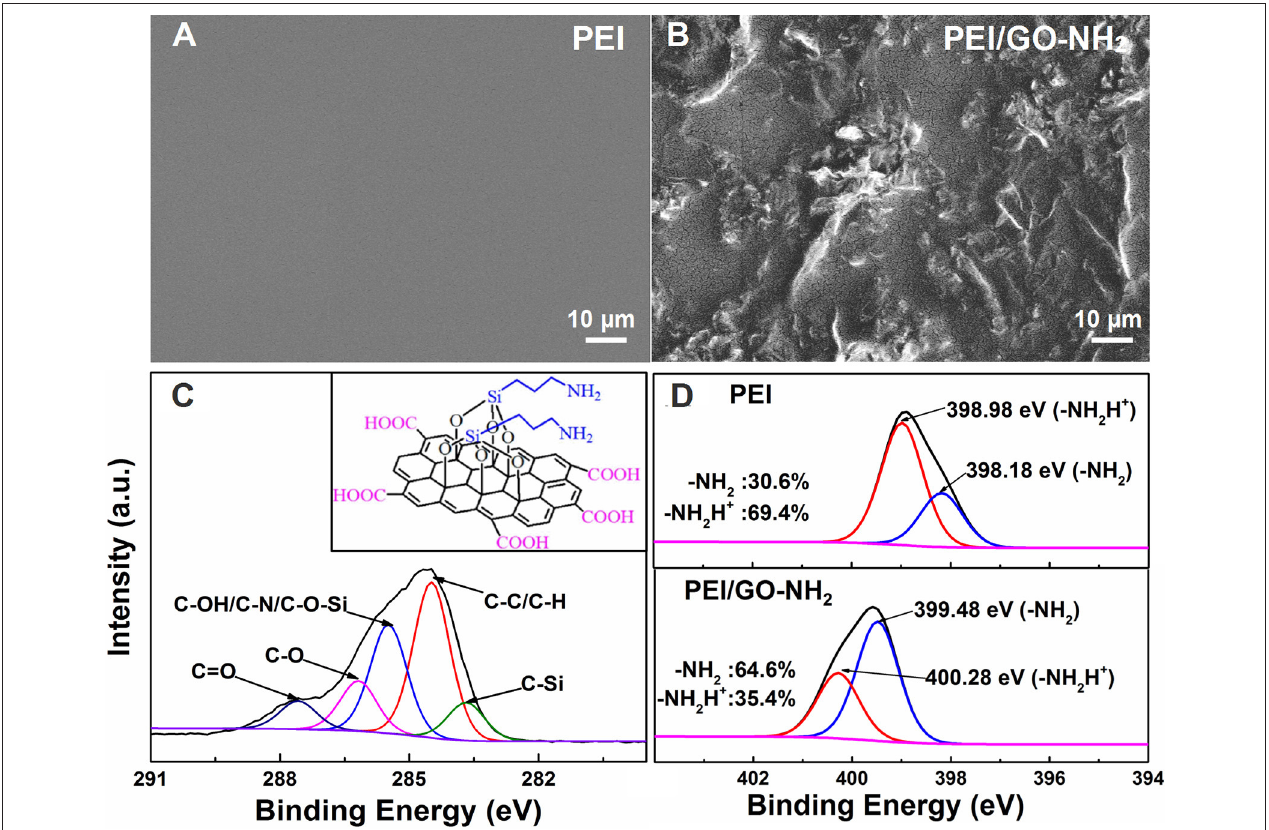
FIGURE 1 | SEM images of (A) PEI and (B) PEI/GO-NH 2 film. High-resolution XPS of (C) C1s spectra of PEI/GO-NH 2 and (D) N1s spectra of pure PEI and PEI/GO-NH 2 , the inset of (C) is GO-NH 2 material